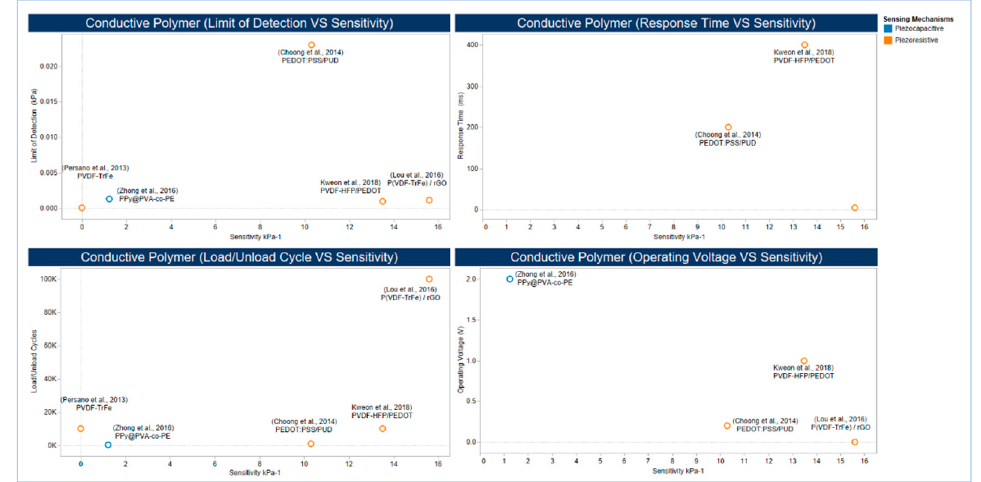
Figure 15. Effect of combined use of rGO and PVDF-TrFe nanofibers on sensor performance. Figure 15. E ff ect of combined use of rGO and PVDF-TrFe nanofibers on sensor